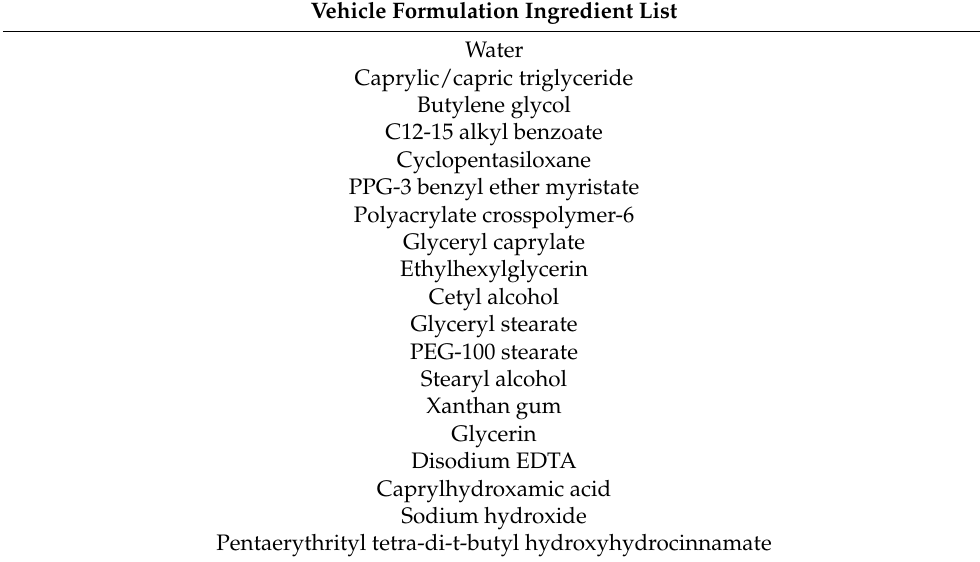
Table 5. Ingredient list of vehicle formulation used during the clinical studies. Ingredients are listed in decreasing order from top to